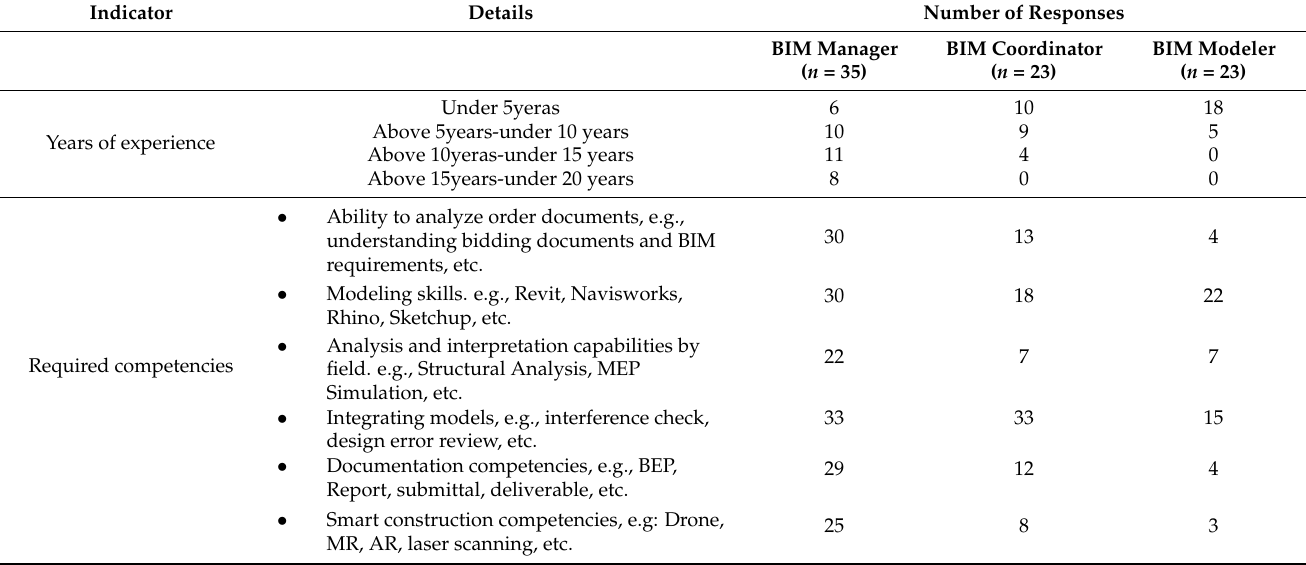
Table 2. Detailed information on the BIM staff years of experience and required